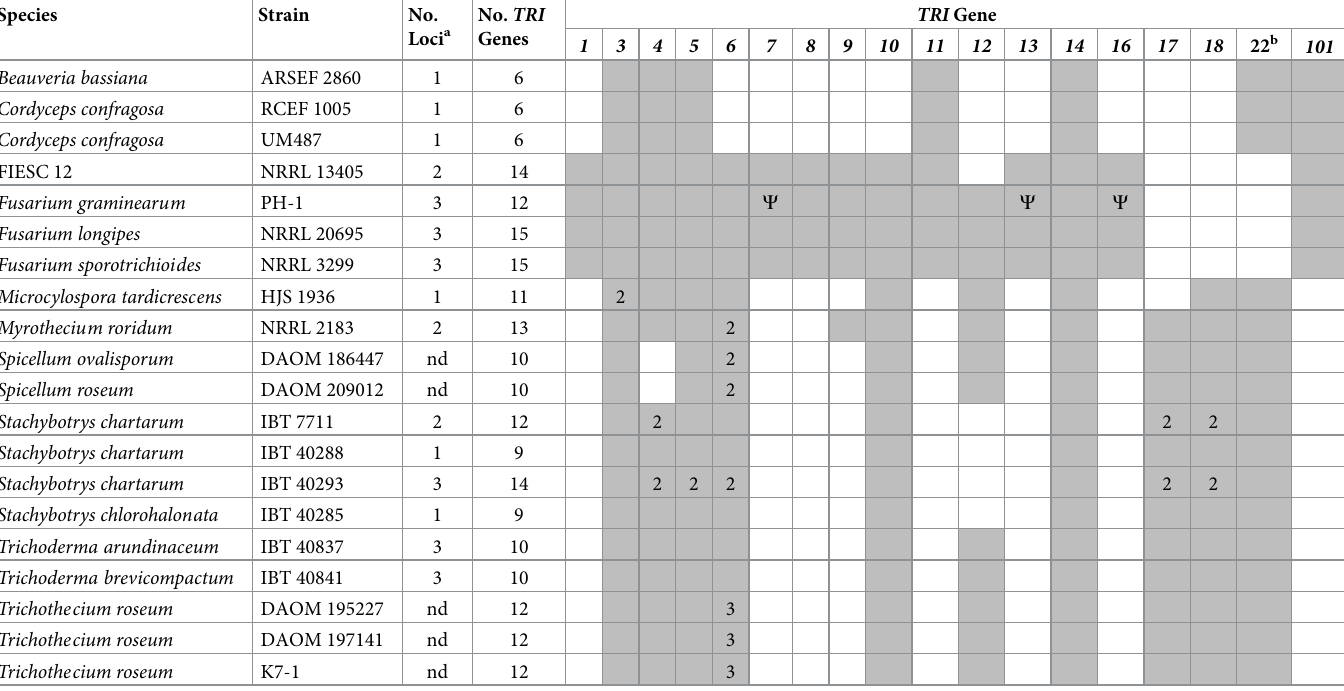
Table 3. TRI gene content of fungi examined in the current study. A gray box indicates that a TRI gene is present in the genome of a fungus, while a white box indicates the gene was not detected. Numbers within boxes indicate the number of paralogs. The Greek letter ψ indicates that a large portion of the gene is present but that it is a pseudogene.